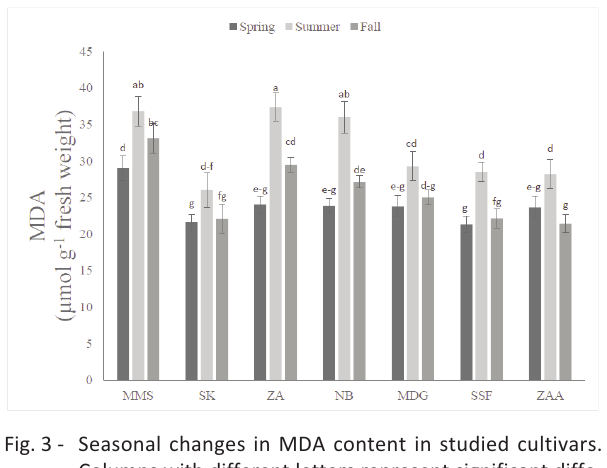
Fig. 3 ­ Seasonal changes in MDA content in studied cultivars. Columns with different letters represent significant diffe­ rences at 5% probability using Duncan’s multiple range test, those are valid for all